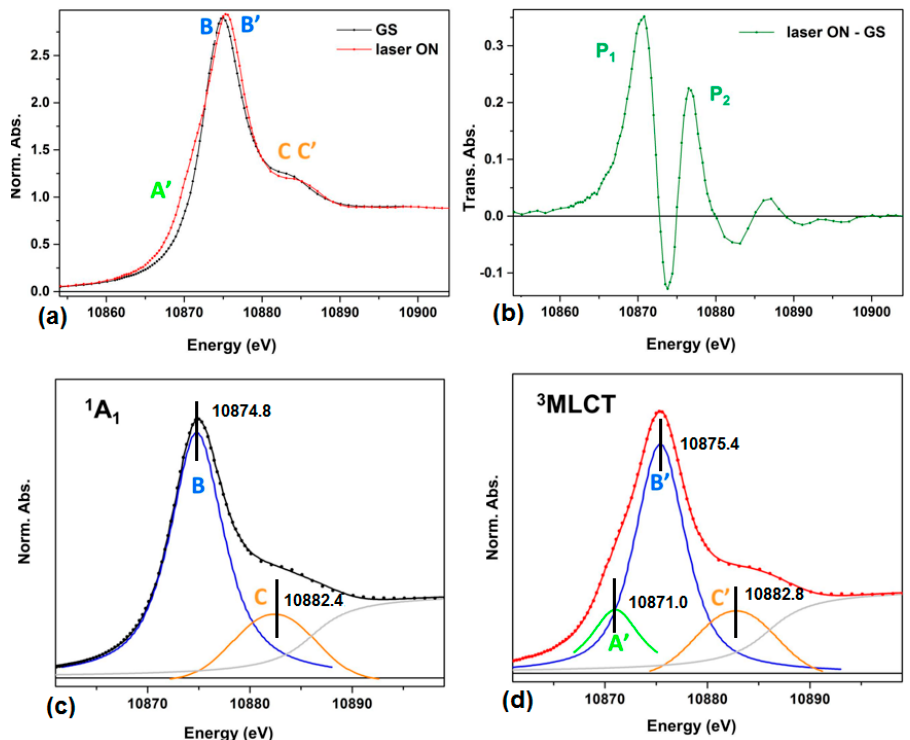
Figure 2. ( a ) Os L III edge XANES spectra of a 1.2 mM solution of [Os(terpy) 2 ] 2+ in methanol without